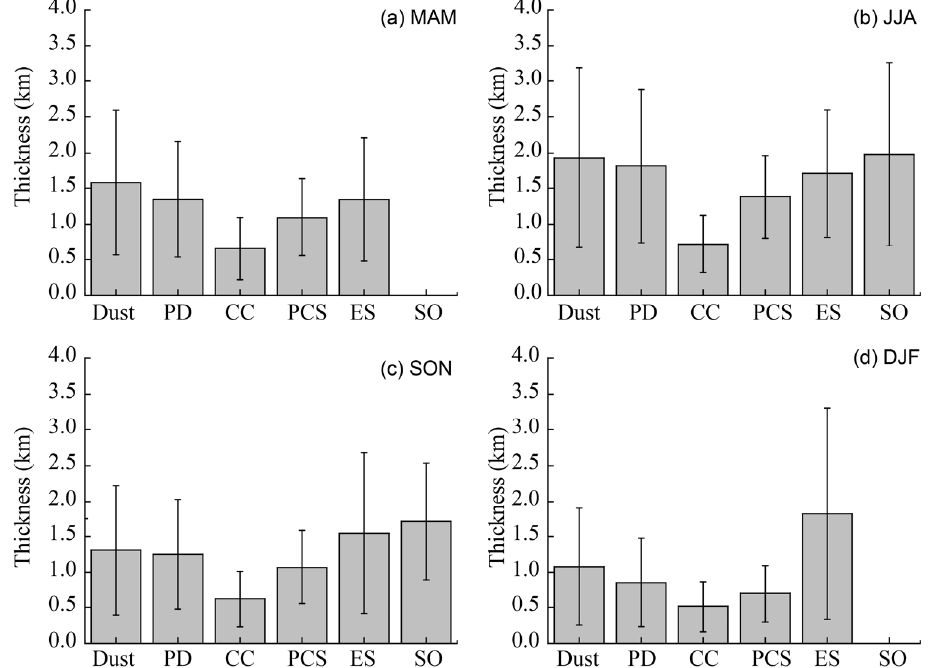
Figure 7. The mean thickness of the aerosol layer over the Aral Sea Basin from 2007 to 2021. (PCS, polluted continental/smoke; CC, clean continental; PD, polluted dust; ES, elevated smoke; SO, sulfate/other).